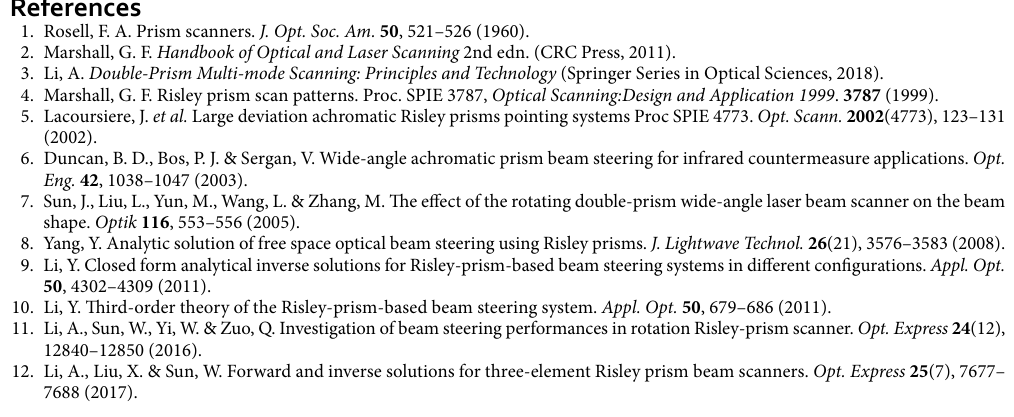
With A = B = 0.33 , D 1 = 20mm , and D 2 = 200 mm , the trajectory and the inverse solutions to ψ 1 and ψ 2 are plotted in Fig. 7a,b, respectively. Substituting the orientations obtained from the inverse solution into the analytic forward solution, we found that the errors are less than 1 μm.